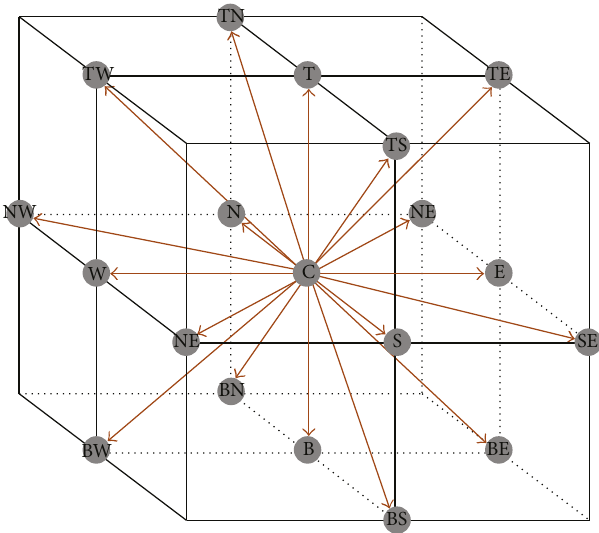
Figure 2: D3Q19 model for the 3-D